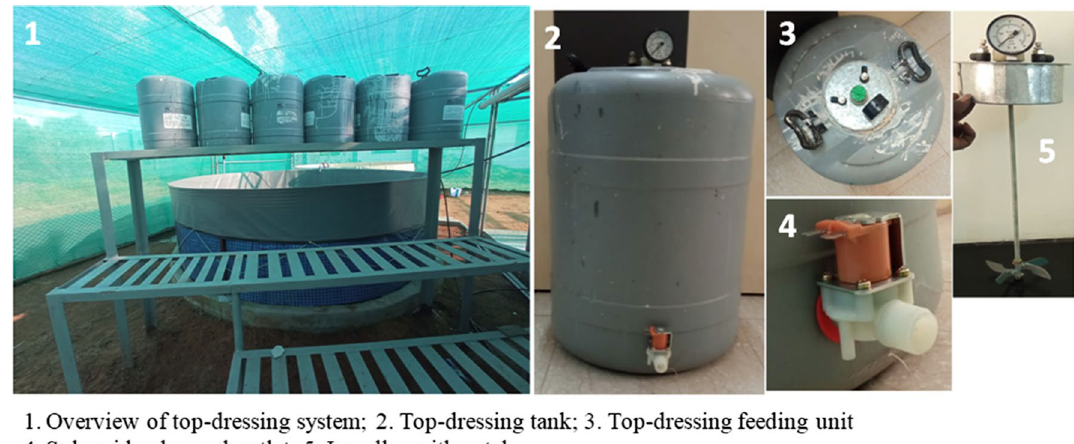
Fig. 3 Top-dressing system with stirring and dispersion units to be used in an aquaculture automation system for Biofloc production of